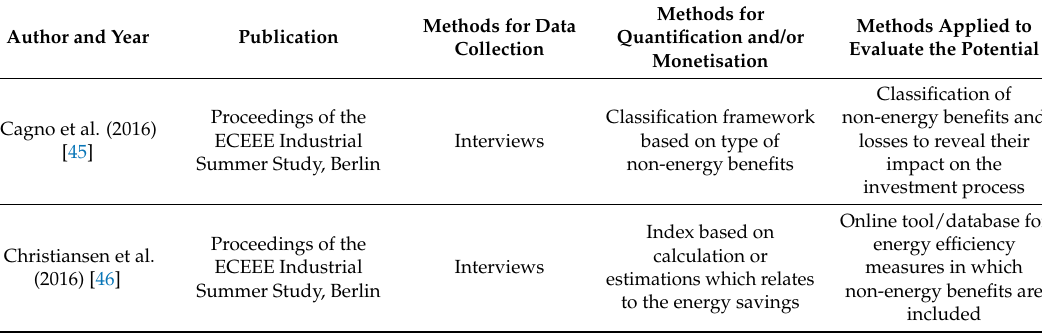
Table A2. A compilation of the methods applied to the study of the non-energy benefits of industrial energy efficiency measures in the reviewed articles. ECEEE—European Council for an Energy-Efficient Economy; ACEEE—American Council for an Energy-Efficient Economy; USA—United States of America; IBIMA—International Business Information Management Association; n/a—not